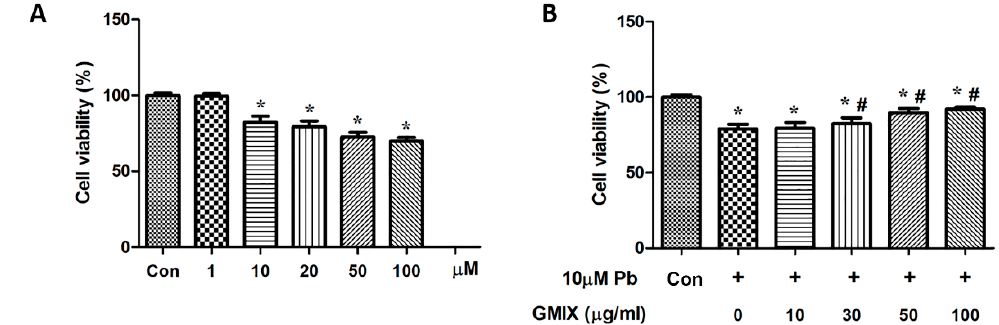
Figure 3. Gangliosides decrease Pb-induced cytotoxicity in HT22 cells. ( A ) Cell viability of HT22 cells after treatment with Pb; ( B ) cell viability of HT22 cells after treatment with GMIX and Pb. The data are expressed as means ± SD of three independent experiments. * p < 0.05 vs. control group; # p < 0.05 vs. Pb group.